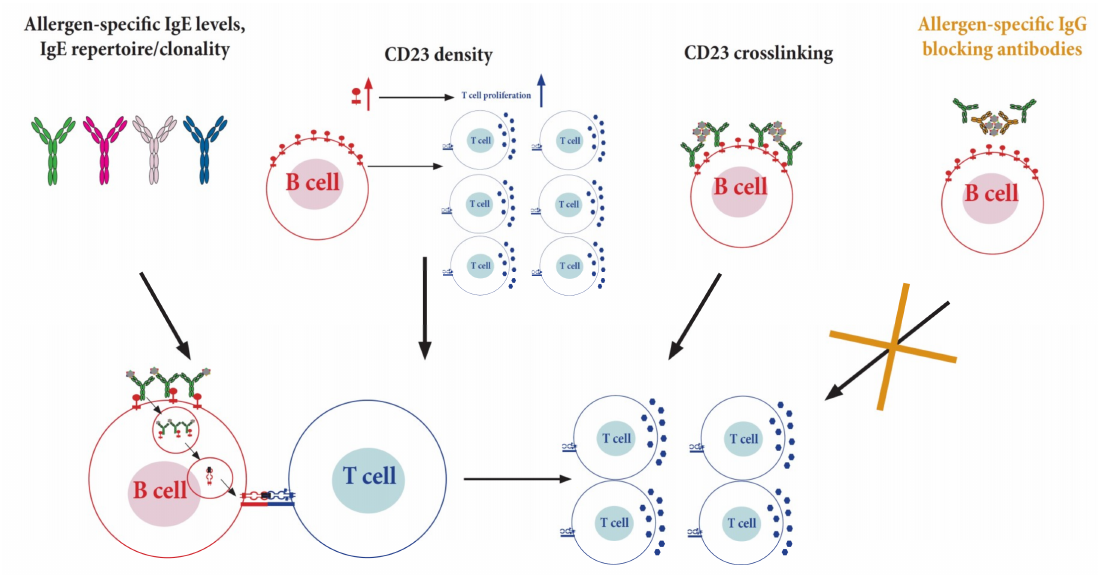
Figure 5. Factors a ff ecting the extent of CD23-mediated facilitated allergen presentation (FAP) and subsequent T cell activation. Binding of IgE-allergen-complexes to CD23 present on B cells (bottom section, red cell) leads to endocytosis of these complexes followed by processing and loading of allergen-derived peptides on MHCII, which can be recognized by specific T cells (blue cells). This process, called IgE FAP, enhances activation and proliferation of T cells. Factors involved in controlling IgE-FAP include allergen-specific IgE levels, IgE repertoire / clonality, CD23 density, the extent of IgE crosslinking, and allergen-specific blocking IgG